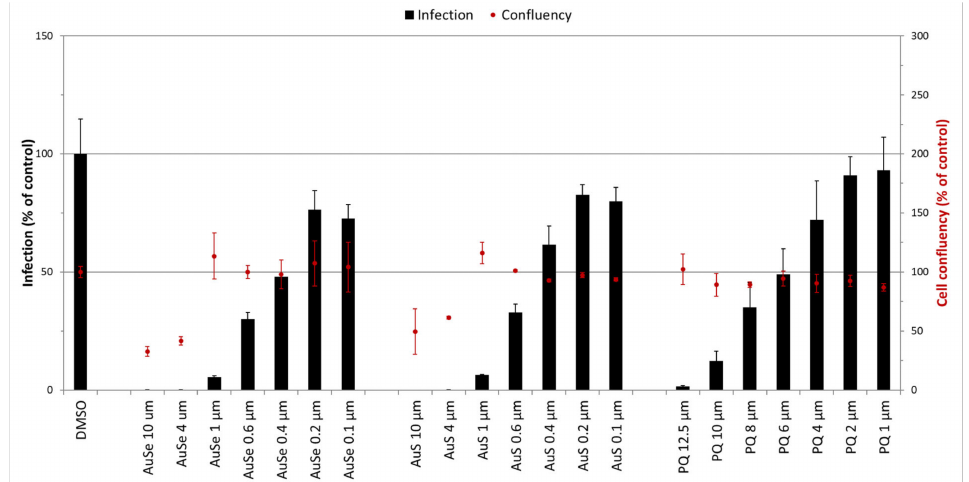
Figure 7. In vitro activity of Au(III) bis(dithiolene) complexes against P. berghei hepatic infection. The inhibitory activity of primaquine (PQ), [PPh 4 ][AuSEt(=Se)] (AuSe), and [PPh 4 ][AuSEt(=S)] (AuS) is represented as a percentage of relative luminescence units of DMSO control. Compound cytotoxicity was measured by fluorescence following AlamarBlue addition and normalized to the DMSO control. Results are expressed as a mean ± the standard